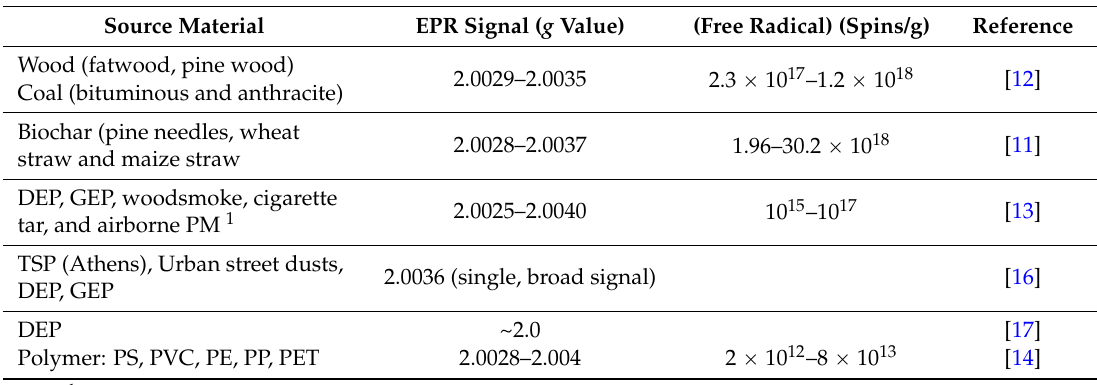
Literature support for the formation of EPFRs formed through the combustion of organic